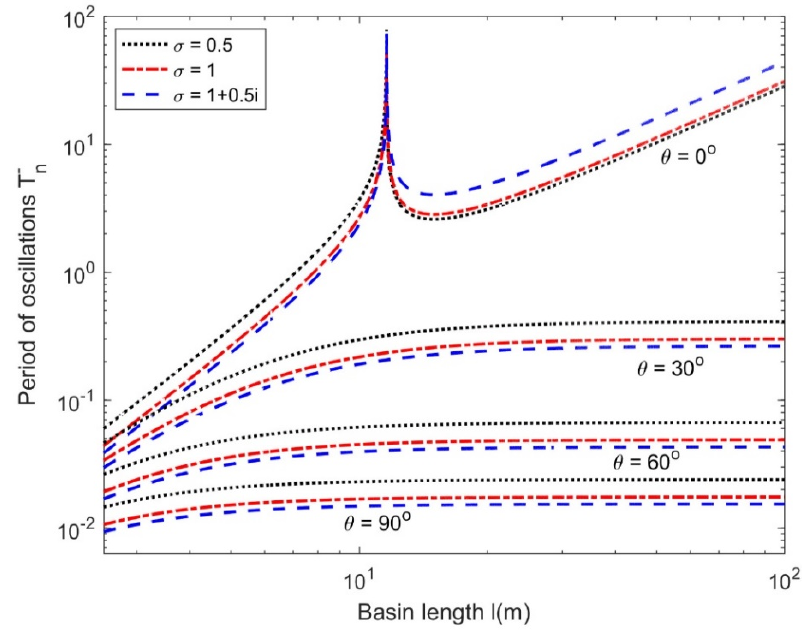
T − for different θ . Figure 17. Effect of porous-effect parameter on T − n for different θ n